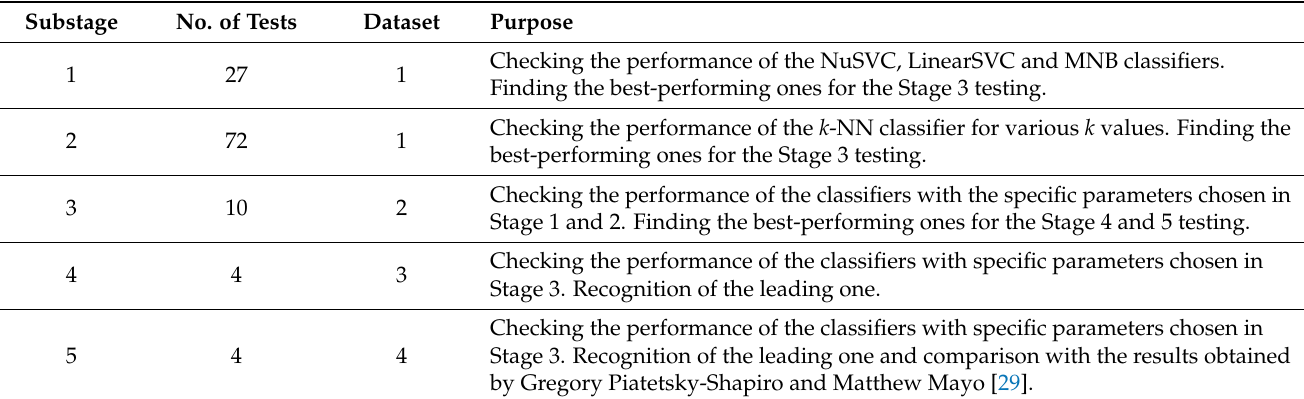
Table 12. Five substages of checking the classifiers